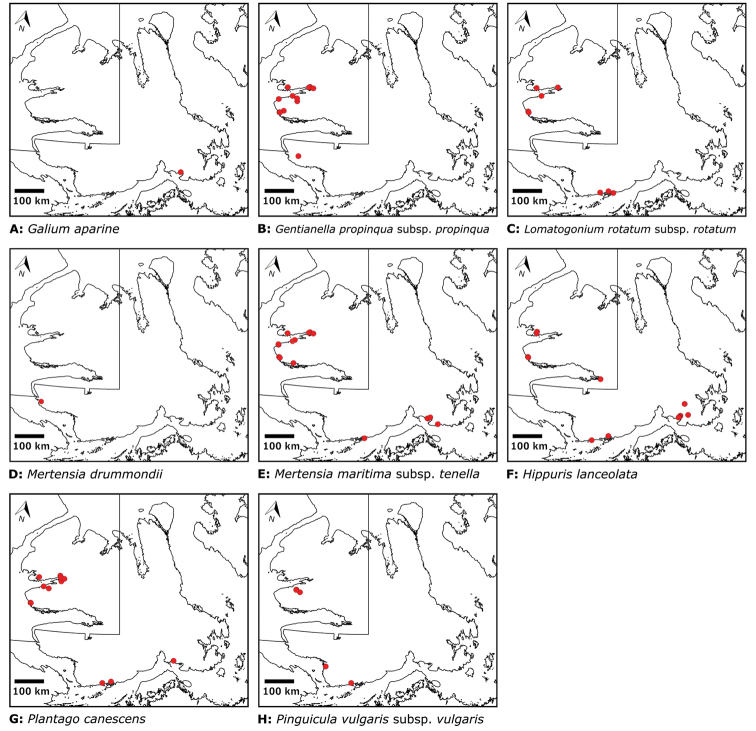
Species distribution maps. Rubiaceae: AGalium
aparine. Gentianaceae: BGentianella
propinqua
subsp.
propinquaCLomatogonium
rotatum
subsp.
rotatum. Boraginaceae: DMertensia
drummondiiEMertensia
maritima
subsp.
tenella. Plantaginaceae: FHippuris
lanceolataGPlantago
canescens. Lentibulariaceae: HPinguicula
vulgaris
subsp.
vulgaris.